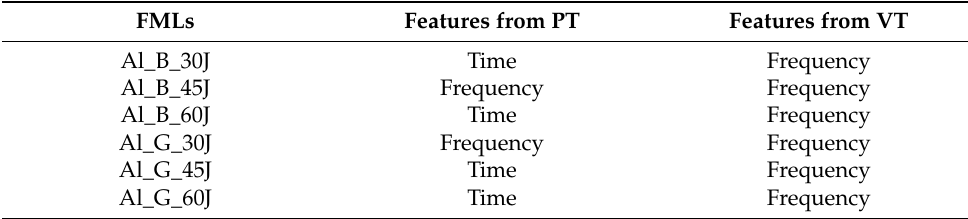
Table 3. Feature images after feature selection on two modalities.